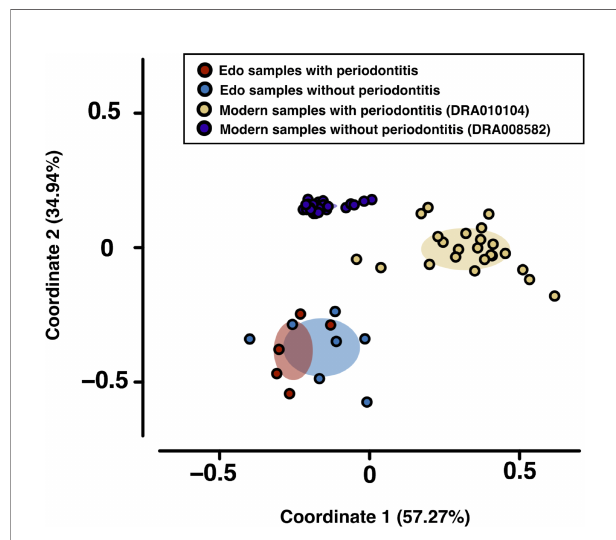
FIGURE 4 | Principal coordinate analysis (PCoA) was conducted for the dissimilarity matrix value of 1 — Spearman ’ s coef fi cient. PCoA was used to evaluate bacterial similarity for comparison between Edo and modern microbiomes according to